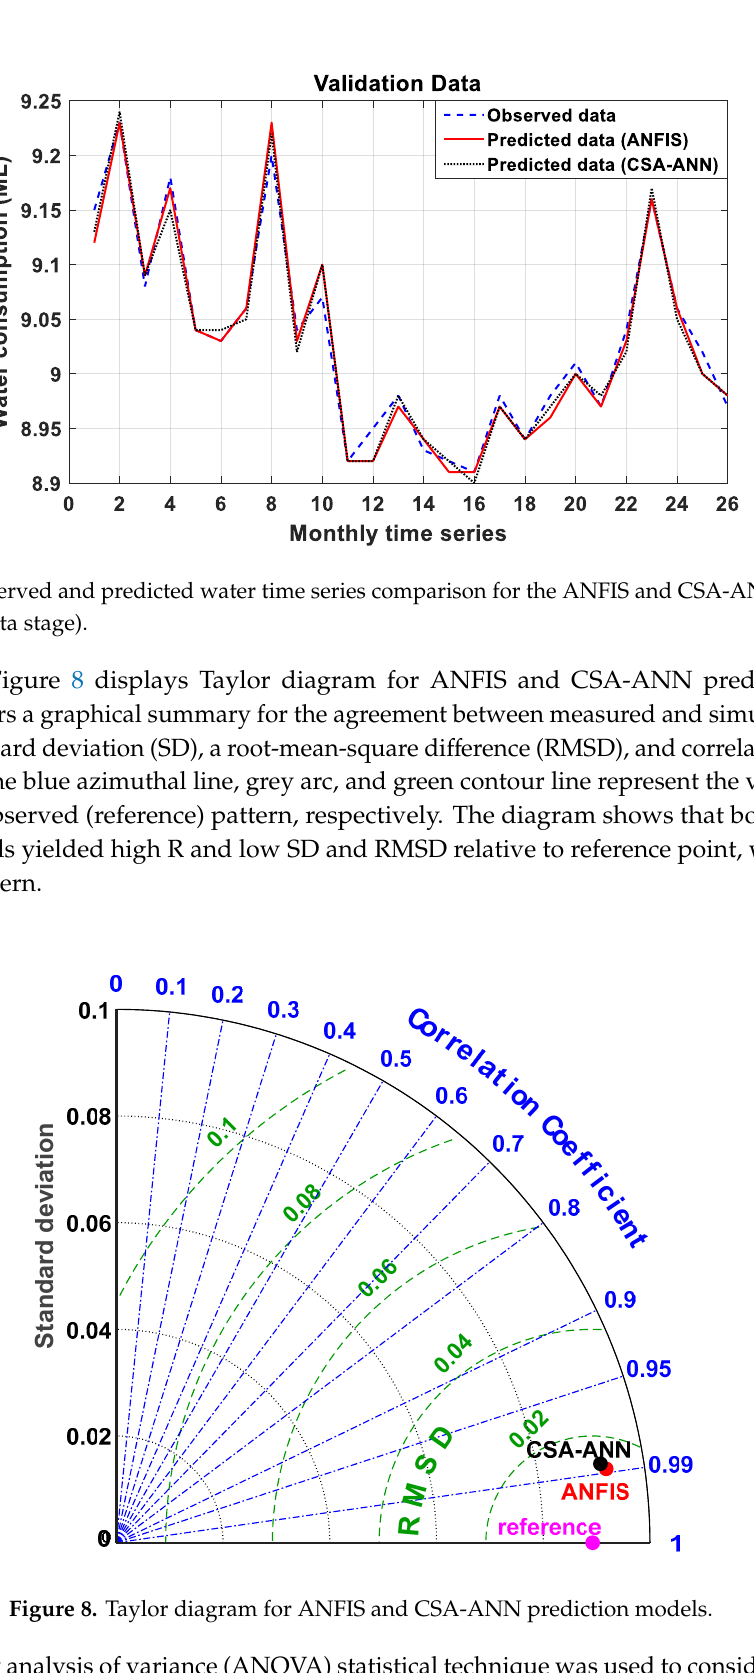
Table 3. Performance evaluation for validation data stage. Technique